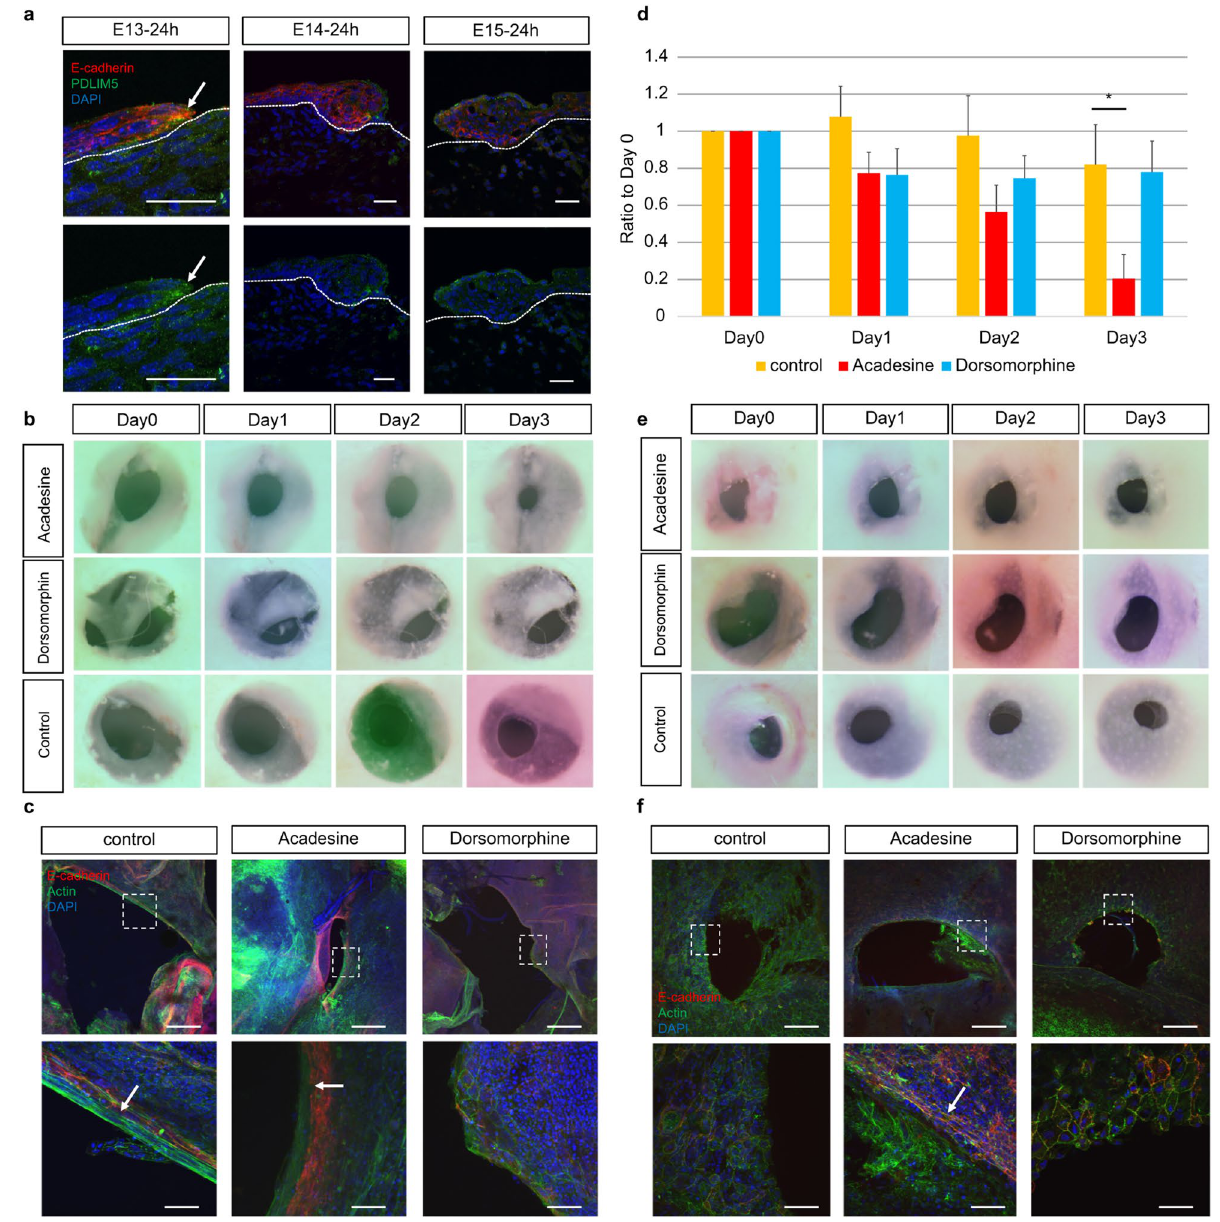
Figure 6. Effect of AMPK activity on wound healing ex vivo. ( a ) PDLIM expression during fetal wound healing. Scale bar = 30 µm. ( b ) Ex vivo regulation of AMPK activity and healing in E13 wounds. ( c ) Regulation of AMPK activity and actin cable formation in E13 wounds. ( d ) Wound area change due to the modulation of AMPK activity in E13 wounds. E: Ex vivo modulation of AMPK activity and healing in E14 wounds. ( ff ) Regulation of AMPK activity and actin cable formation in E14 wounds. ( g ) Change in wound area by modulating AMPK activity in E14 wounds. H: Ex vivo AMPK activity regulation and healing in E15 wounds. ( i ) Regulation of AMPK activity and actin cable formation in E15 wounds. ( j ) Changes in the wound area due to modulating AMPK activity in E15 wounds. *P < 0.05 (statistically